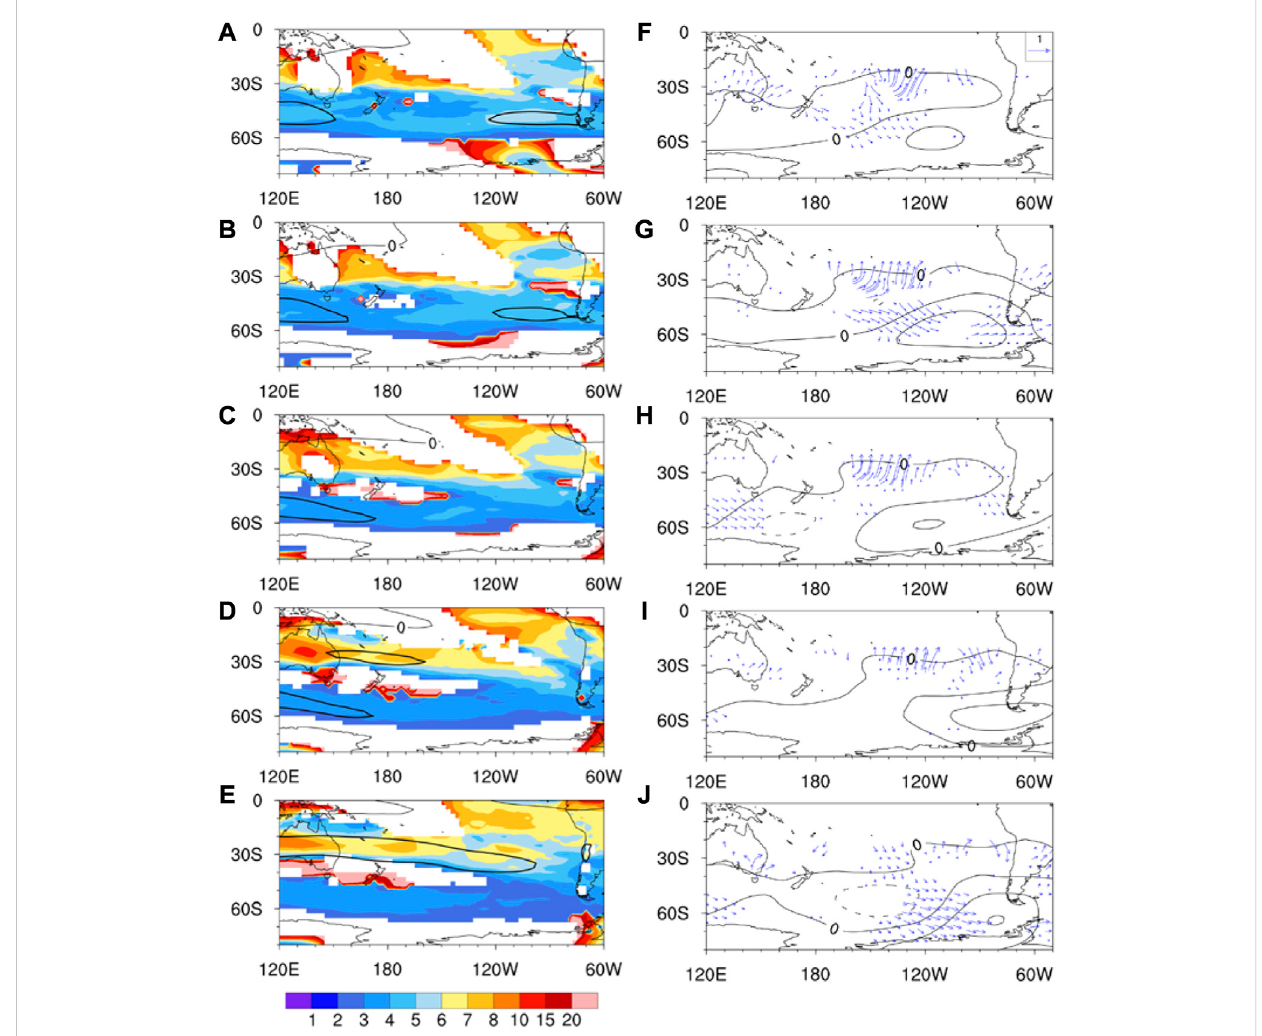
FIGURE 4 Thetotalwavenumber(shaded,unitsofa − 1 ,whereaistheradiusoftheearth)at250 hPaforthezonalwavenumber2andforthenegativemeridional wavenumber in each month from (A – E) January to May (left panels). The contour represents the 250-hPa climatological zonal wind velocity (m s – 1 ), and the 0 and 30 m s – 1 wind are represented by thin and thick lines, respectively. Regression maps of the 500-hPa geopotential height anomaly (contour, intervals of 20 m) and corresponding 250-hPa wave activity fl ux (vector, m 2 s – 2 , less than 0.01 m 2 s – 2 is not drawn) from (F – J) January to May (right